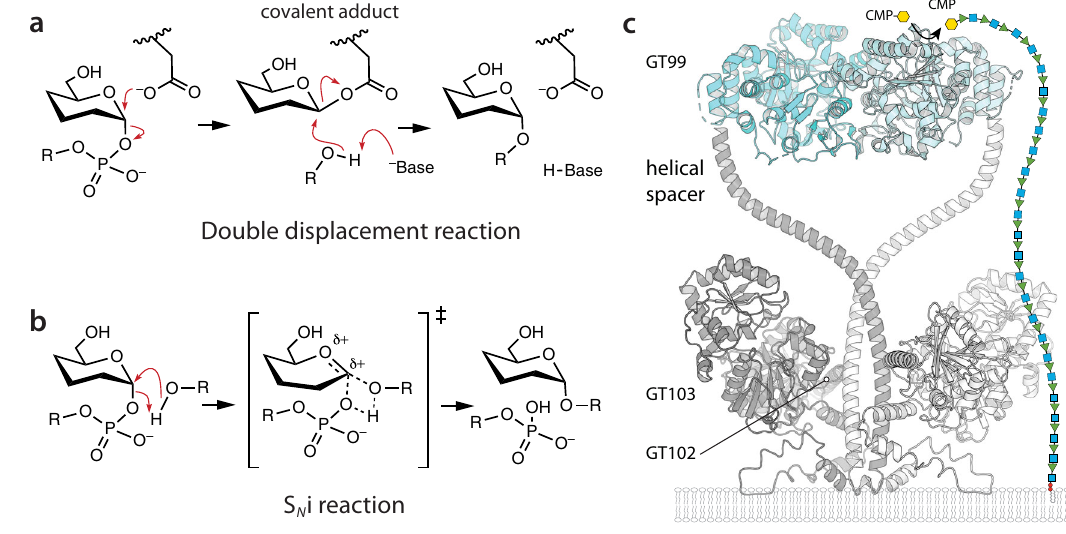
Fig. 1 | Mechanisms of retaining GTs. a Two potential mechanisms have been proposed for retaining GTs. A double-displacement mechanism would follow the pattern generally seen among other enzymes, including glycosyl hydrolases, but has never been unambiguously demonstrated for any GT. b Instead, all well- characterized retaining GTs appeartouse anS N imechanism,wherethe phosphate dissociates from the donor to form a cationic intermediate, which then reactswith